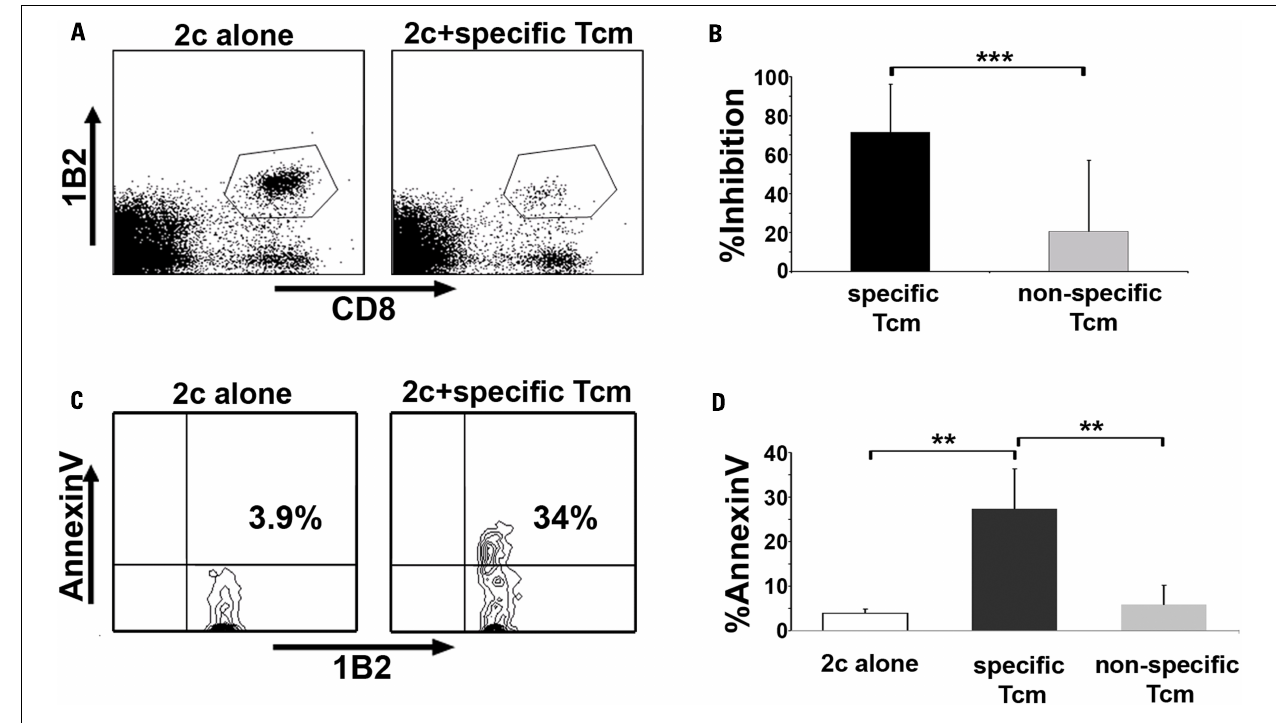
FIGURE 2 |Anti-third-partyTcm are endowed with potent in vivo veto activity. (A,B) Lethally irradiated C57BL/6 (H-2 b ) mice received 1 × 10 5 CD8 + purifiedTCR-transgenic 2c cells (carryingTCR with anti H-2 d specificity) and 5 × 10 5 irradiated BALB/c (H-2 d ) splenocytes.The following day, the mice were transplanted with 1 × 10 6 C57BL/6-NUDE BM cells or received, in addition, 5 × 10 6 “specific,” derived from CB6 (H-2 bd , black bars), or “non-specific”, derived from C57BL/6 (H-2 b , gray bars) anti-third-partyTcm. Recipients were sacrificed 8 days post-transplant, their spleens were harvested, and the deletion of anti-donor 2c T cells was monitored by FACS. (A) Representative result demonstrating the level of surviving (7AAD − ) 2c cells in the absence (left panel, “2c alone”) or presence of “specific”Tcm (right panel “2c + specificTcm”). (B) Quantification of results demonstrating efficient inhibition of the 2c cells only by “specific” and not by “non-specific” “Tcm.” Data represent average ± SD of percent inhibition from at least 10